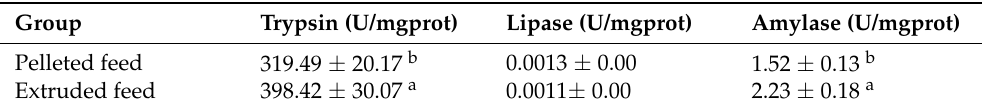
Table 5. Effects of pelleted and extruded feeds on digestive enzyme activities in the intestine of P. clarkii .